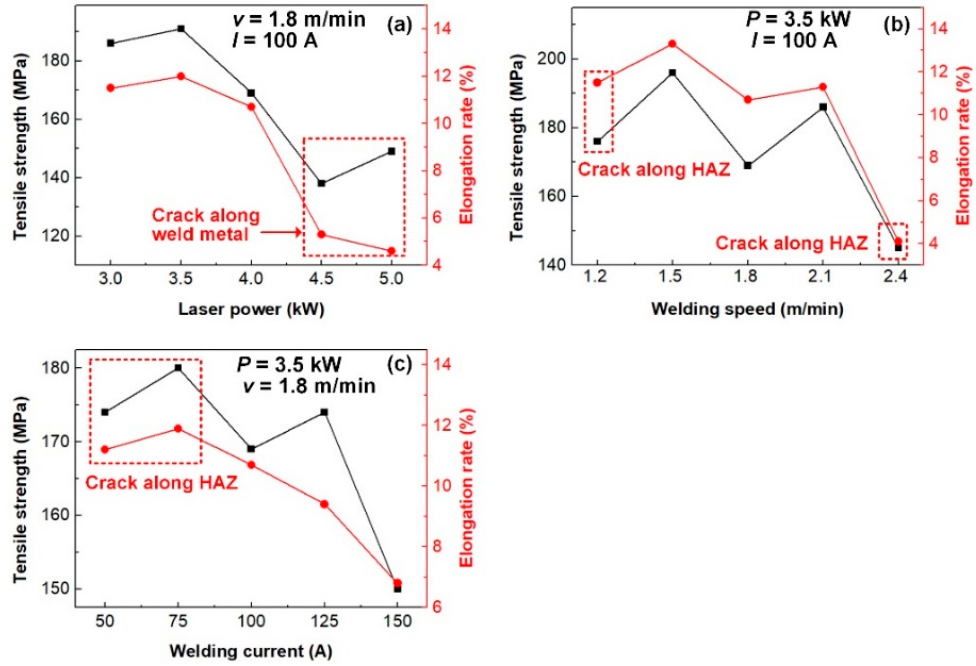
Figure 10. Relationship between processing parameters and tensile properties; ( a ) laser power, ( b ) welding speed and ( c ) welding current.